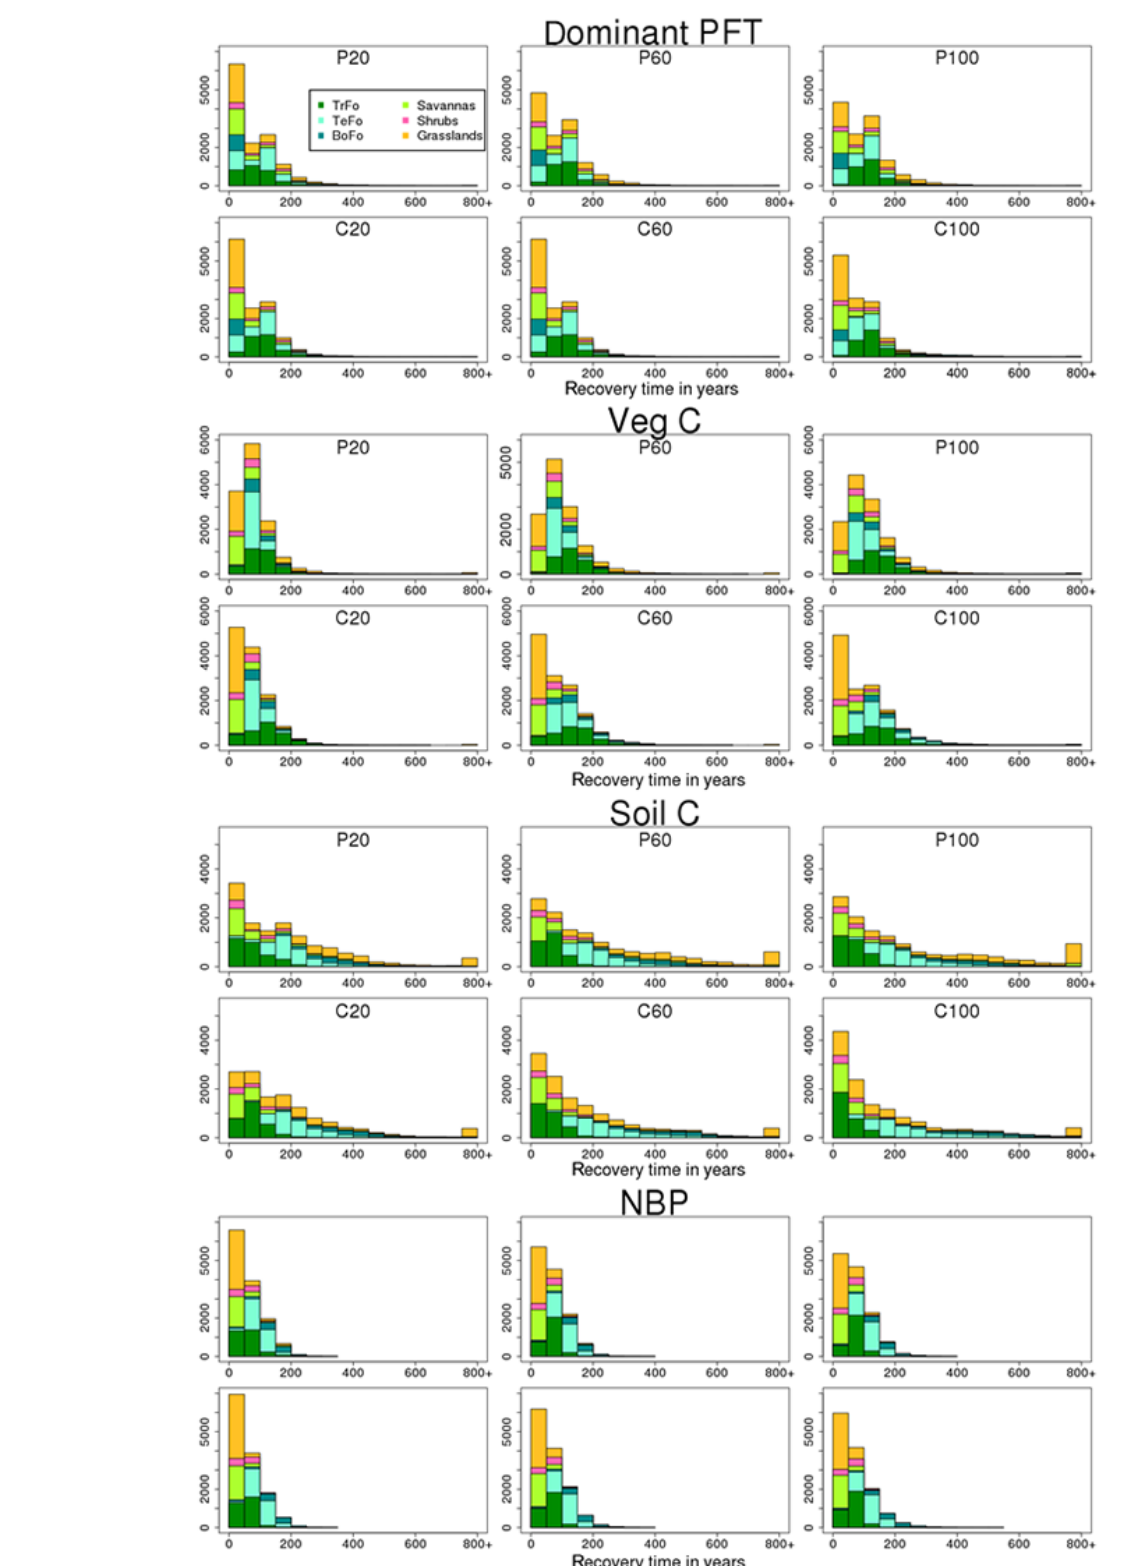
Figure A2. Histograms of recovery times for the dominant PFT, vegetation C, soil C, and NBP for the six experiments. Colors indicate different